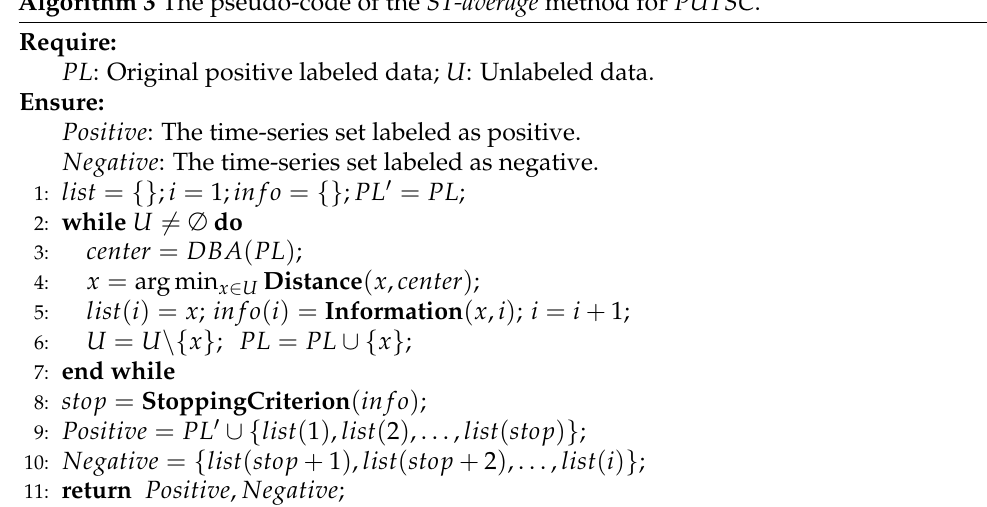
Figure 6. An illustration of the first four iterations of the ST-average . In each iteration, ST-average first computes average sequence C and then labels the time-series which is closest to C . Algorithm 3 The pseudo-code of the ST-average method for PUTSC